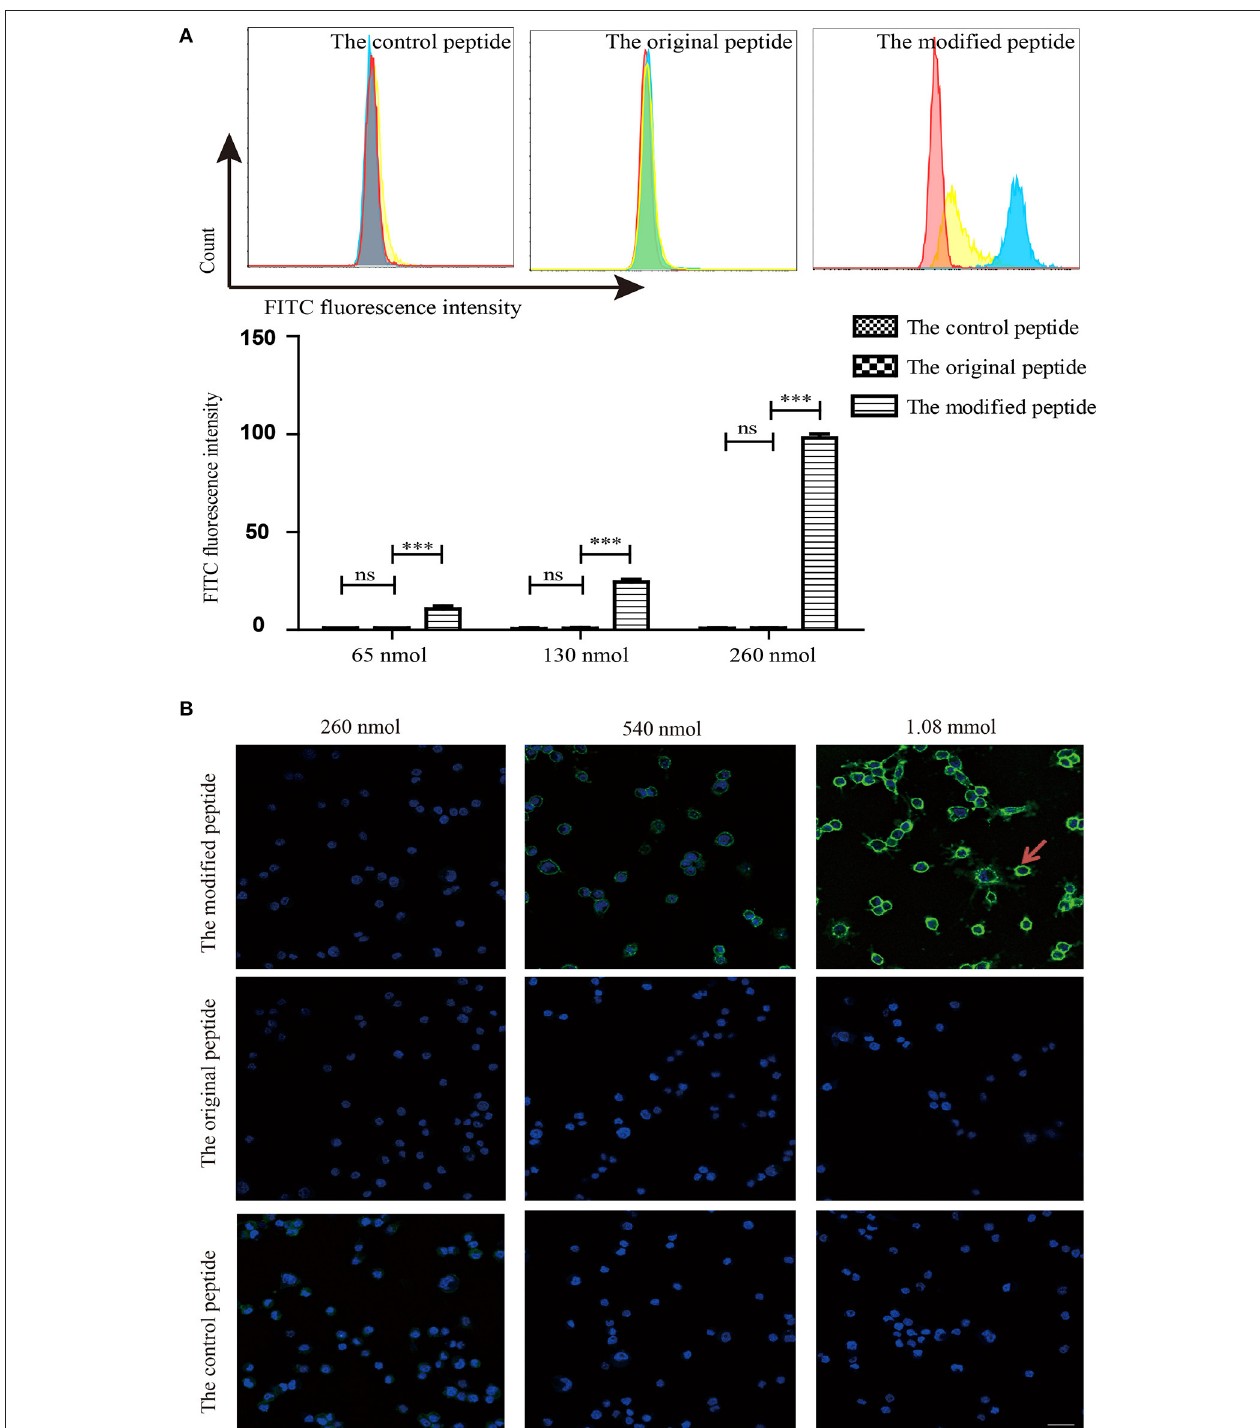
FIGURE 3 | Modified peptide non-specifically bound to the cell surface. (A) Binding of peptides to the surface of mouse ATDC5 cells measured by flow cytometry. All experiments were performed three times and data are presented as mean ± SD. n = 5, *** p < 0.001, ns: not significant ( p > 0.05). (B) Binding of various concentrations of biotin-labeled peptides on the surface of mouse ATDC5 cells assessed by confocal laser scanning microscopy. Arrowheads indicate the binding of the modified peptides on the surface of mouse ATDC5 cells.